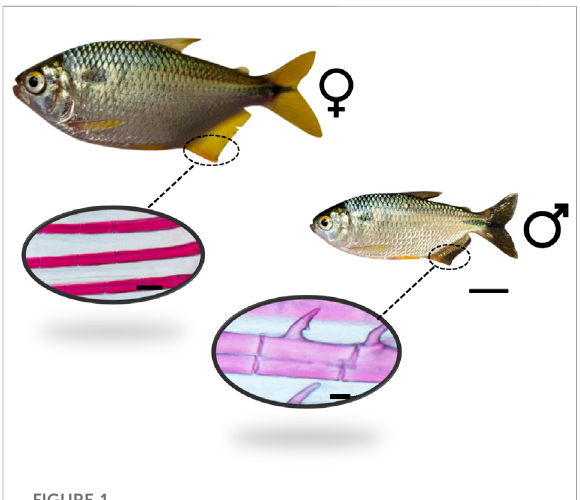
FIGURE 1 Adult male and female yellowtail tetra Astyanax altiparanae . The male presents bony hooks in the anal fi n, which are not present in the females. Bar scale is 1 cm for the fi sh, 50 µm for the male fi n, and 100 µm for the female fi